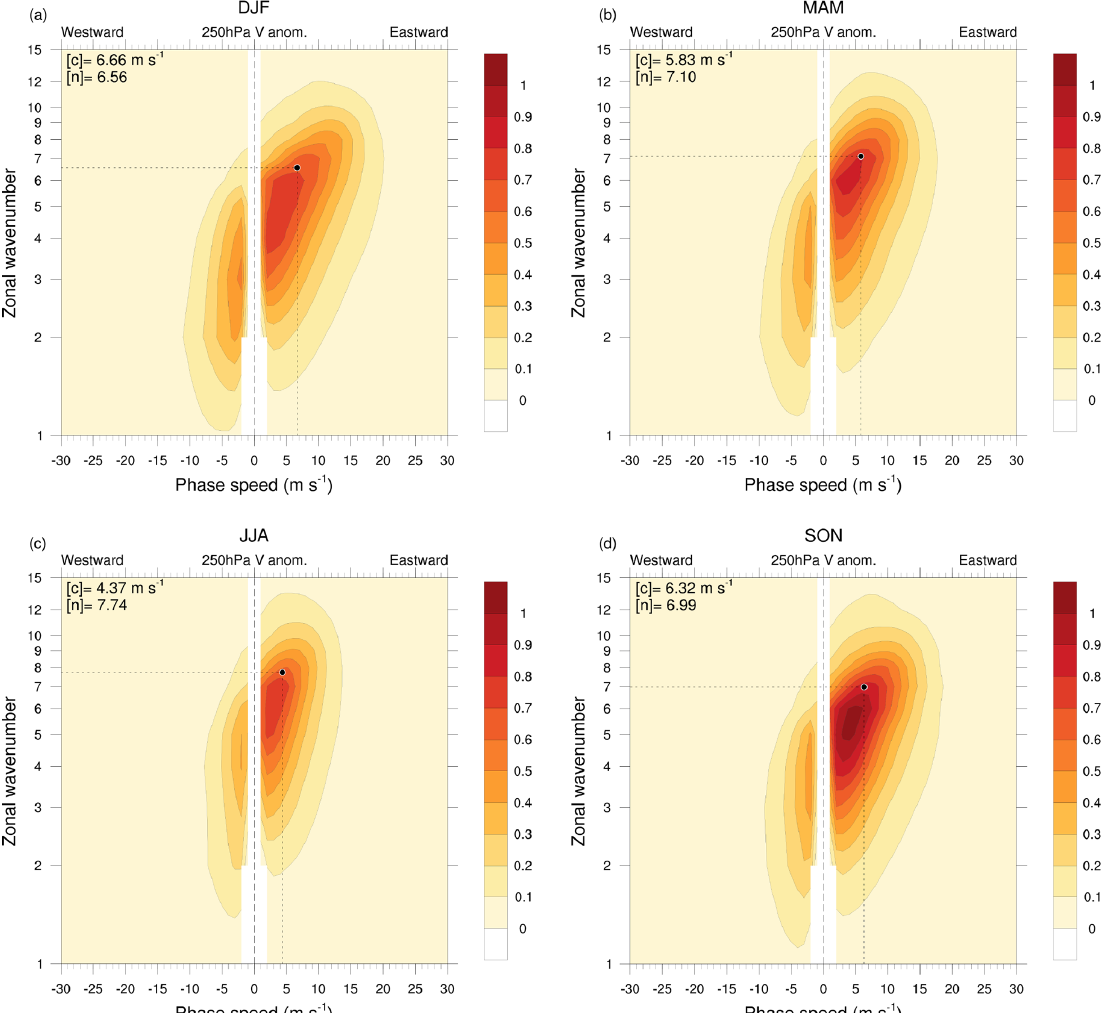
Figure 1. Mean of daily wavenumber–phase-speed spectra of meridional wind anomaly at 250hPa, computed along each latitude circle between 35.25 and 75 ◦ N, every 0.75 ◦ N, during the four seasons: (a) DJF, (b) MAM, (c) JJA and (d) SON. Units of spectra are m 2 s − 2 (cid:49)c − 1 , where (cid:49)c = 1ms − 1 at 55 ◦ N, and values of S(n,c p ) are multiplied by n because of the logarithmic scale adopted for the wavenumber axis. Black dots indicate the phase speed [ c ], as in Riboldi et al. (2020), and the average wavenumber [ n ], both expressed as a weighted averages with respect to spectral power. The respective values are reported in the top left corner of each